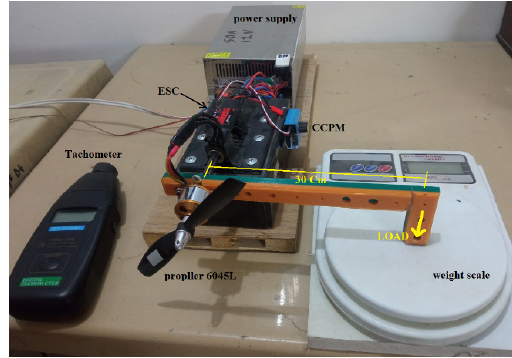
Figure 4. The developed test rig to find the aerodynamic moment constant ( K h )